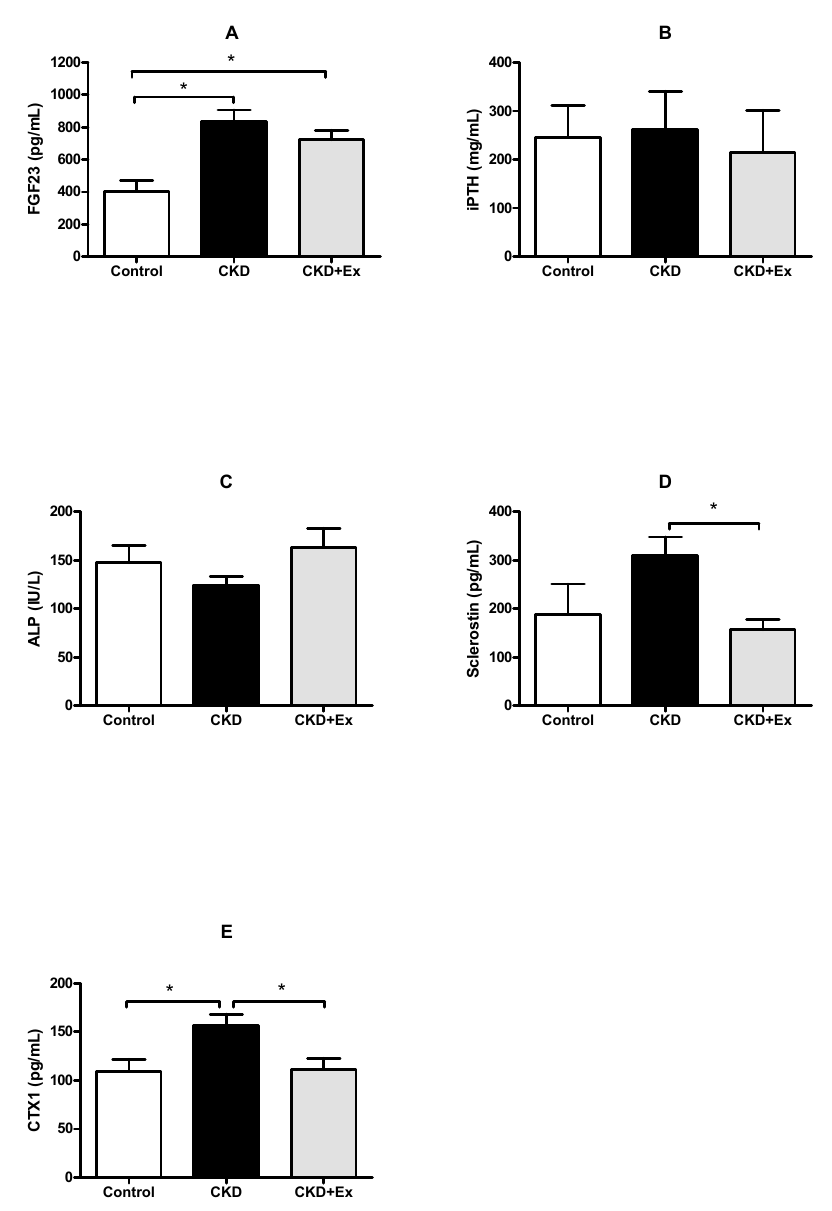
trabecular number (Tb.N), and trabecular separation (Tb.Sp) (space between trabeculae). The values of the trabecular bone microarchitecture parameters in rats from the CKD + exercise group were higher when compared to the rats from the CKD groups (Figure 3D,E,F). The Tb.Sp did not show a significant di ff erence. These data indicated that the rats from the CKD + exercise group had a better Int. J. Mol. Sci. 2019 , 20 , x FOR PEER REVIEW bone microarchitecture than the rats from the CKD group.